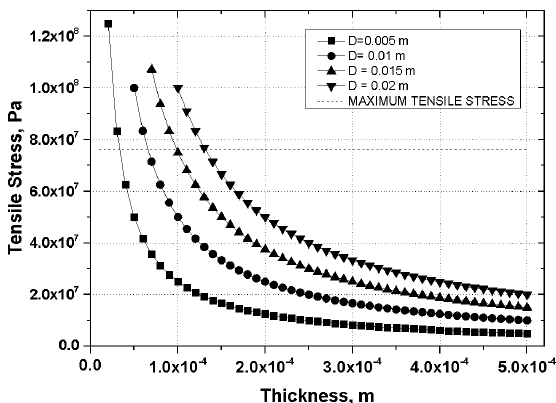
Figure 6. Tensile stress values vs. the membrane thickness for different tube diameters at 623 K and 1 MPa lumen pressure. 1 MPa lumen pressure.